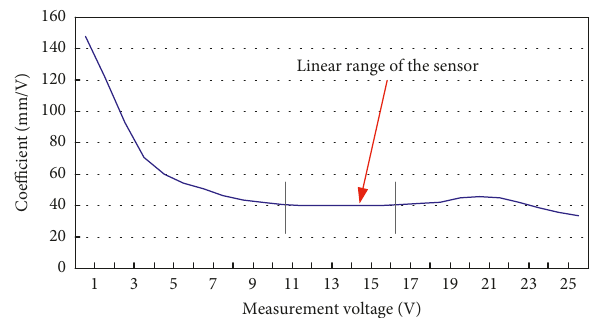
Figure 9: Coefficient of the using